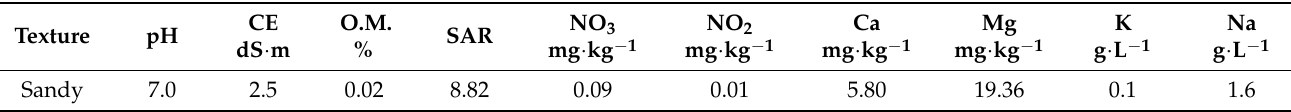
Table 3. Physical and chemical parameters of the substrate in the experimental basins under conditions of the Altar desert,